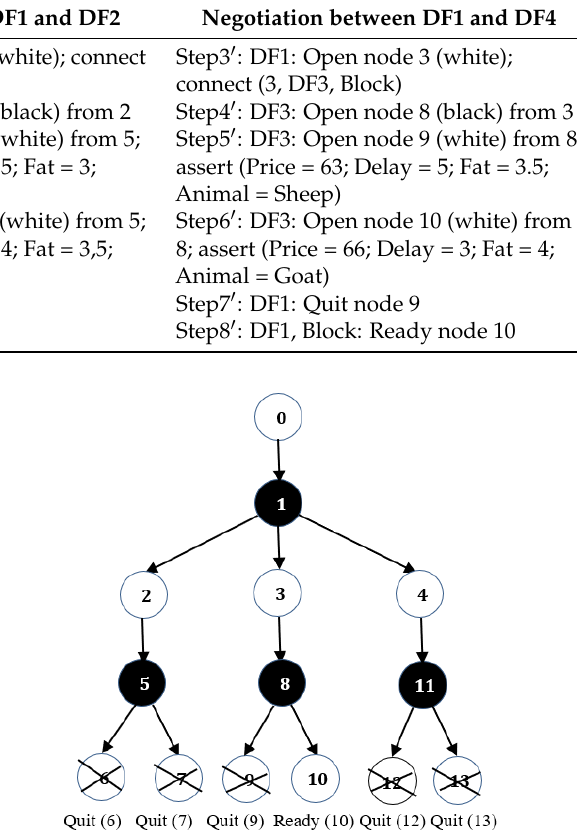
Figure 10. Negotiation graph for the initiator DF1.